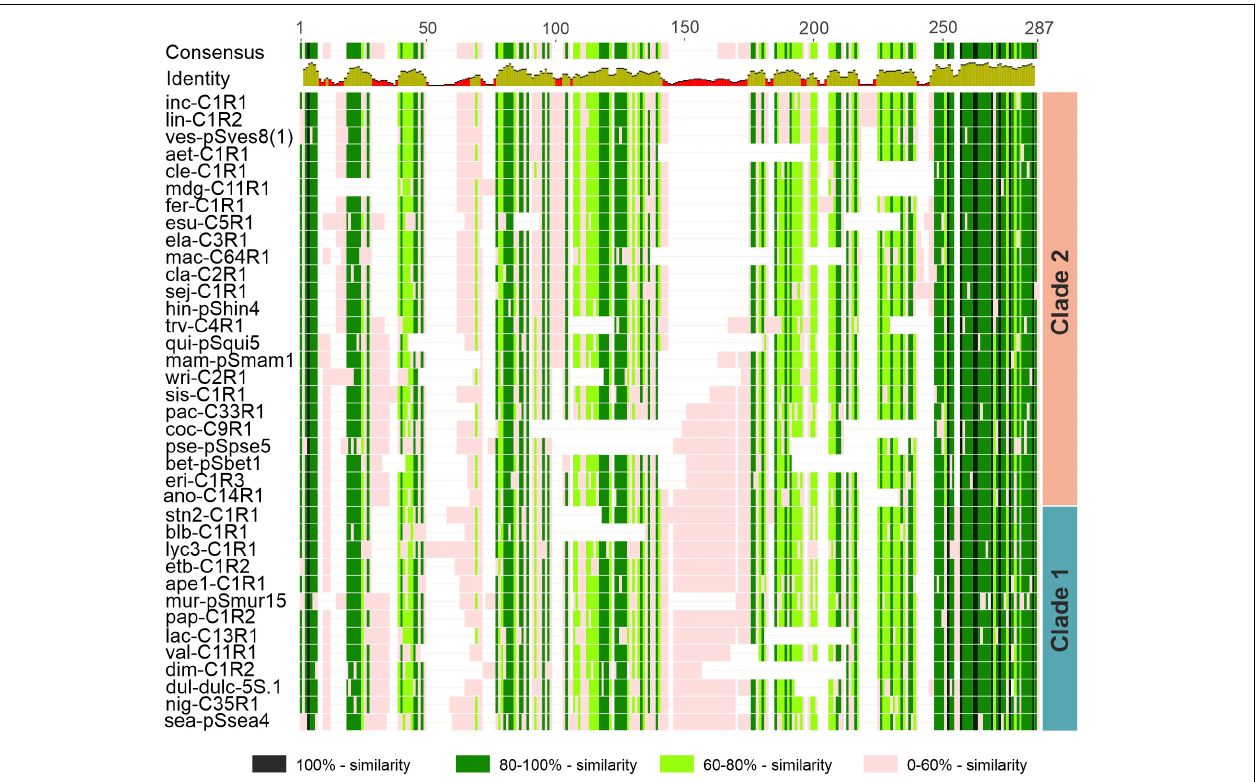
FIGURE 5 | Schematic representation of the sequence alignment of the 5S rDNA IGS of distantly related Solanum species. The level of sequence similarity is shown in different colors. Abbreviations of species names are given in Table 1 . Taxonomic assignment of species to Clades 1 and 2 in the maximum likelihood (ML) dendrogram (see Figure 7 ) is